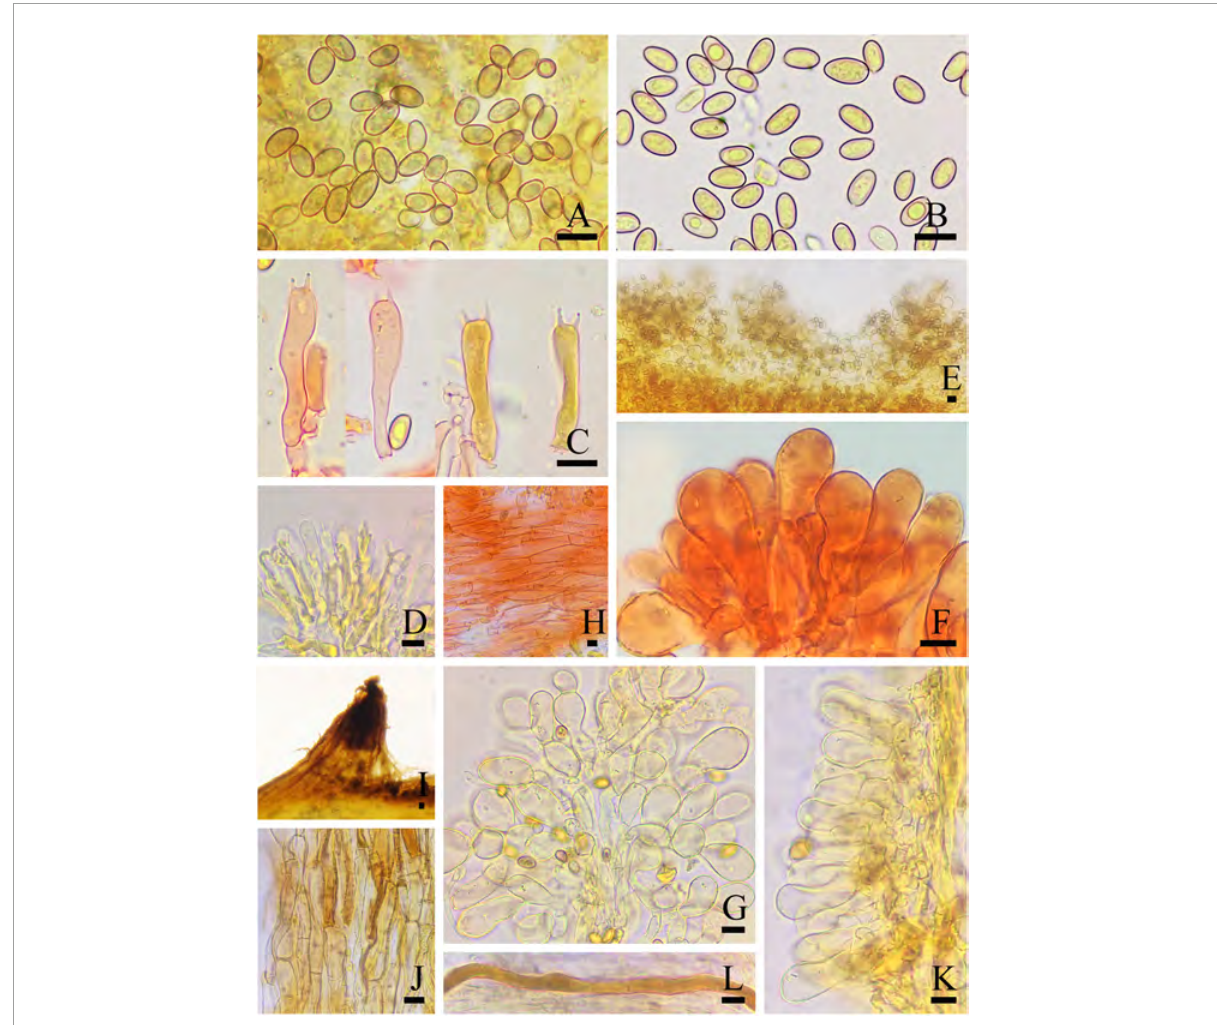
FIGURE9 Microscopic features of Inosperma squamulosobrunneum (MHHNU32359, holotype). (A,B) Basidiospores; (C,D) basidia with probasidium; (E) gill edge; (F,G) cheilocystidia; (H) hymenial hyphae; (I,J) pileipellis; (K) caulocystidia; and (L) oleiferous hyphae. Scale bars = 10 µ m.